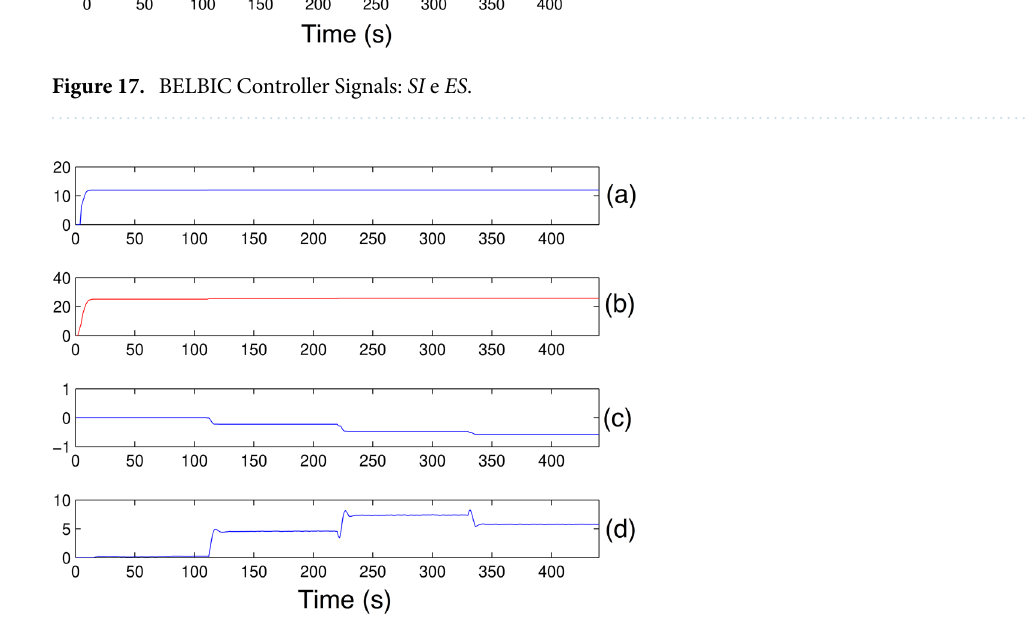
Figure 18. Amygdala and orbitofrontal cortex weights: V e W